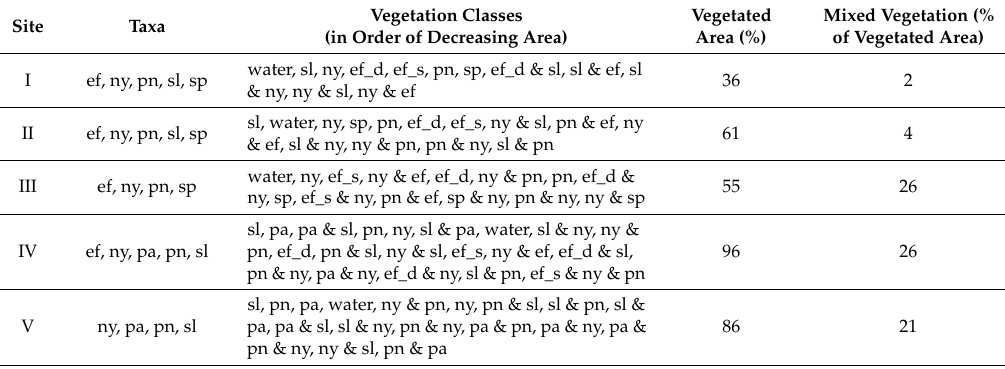
Table 2. Test site description including vegetation classes as derived from the manual mapping; dense Equisetum fluviatile (ef_d), sparse E. fluviatile (ef_s), Nymphaea / Nuphar spp. (ny), Phragmites australis (pa), Potamogeton natans (pn), Schoenoplectus lacustris (sl), and Sparganium spp. (sp). Vegetation Classes Vegetated (in Order of Decreasing Area) Area